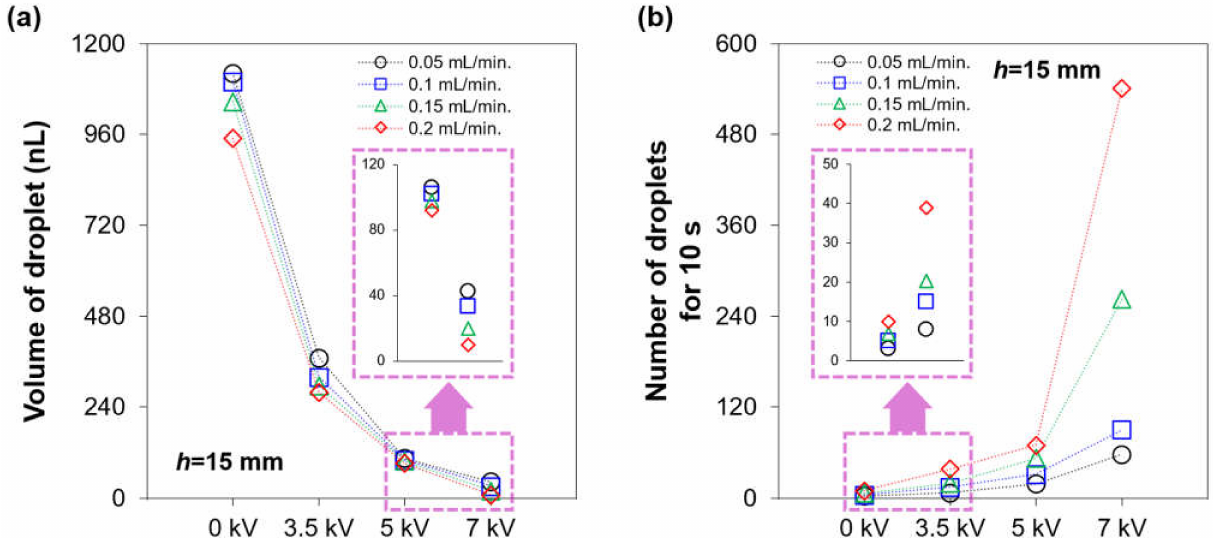
Figure 4. Impacts of the applied voltages and flow rate on the ( a ) volume and ( b ) number of the generated gallium-based liquid metal droplets for 10